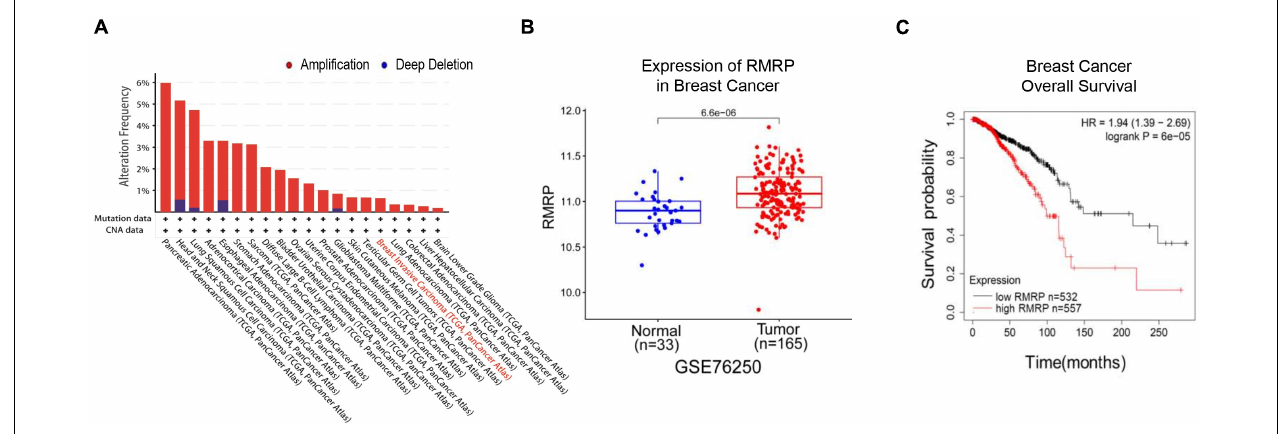
FIGURE 1 | RMRP is associated with poor survival of breast cancer patients. (A) The genomic alterations of the RMRP gene in various human cancers from the TCGA database. (B) RMRP is expressed at a higher level in breast cancer compared to normal tissues from the GEO database. (C) The Kaplan-Meier analysis shows that high expression of RMRP is correlated with unfavorable overall survival of breast